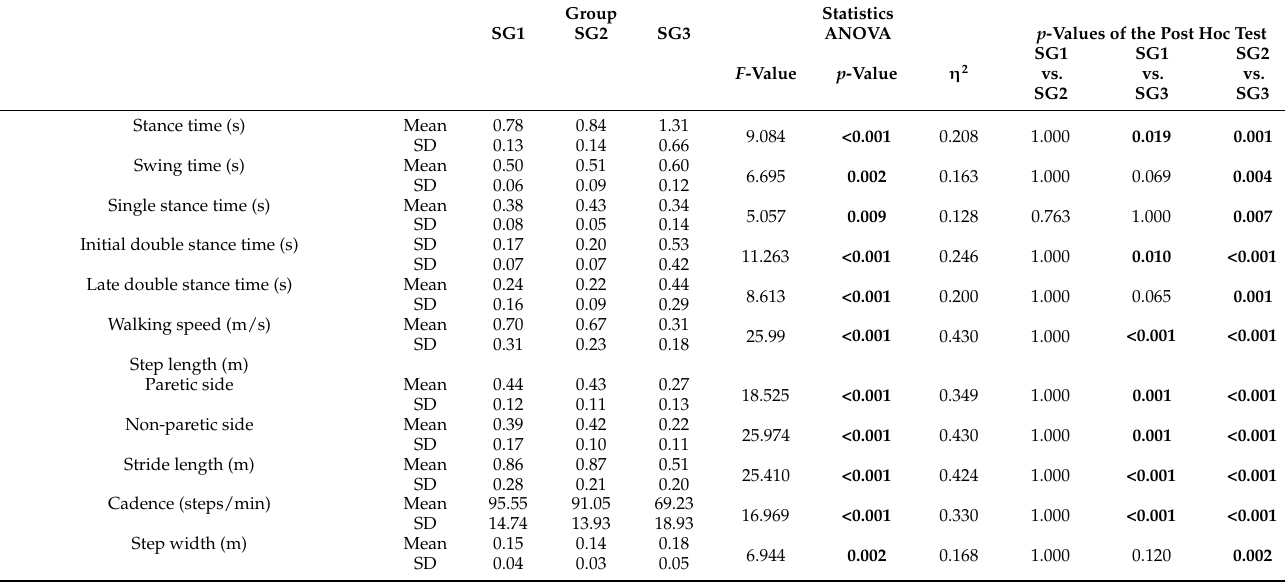
Table 2. Gait spatiotemporal parameters measured using a three-dimensional motion analysis system in the three subgroups. Group Statistics SG1 SG2 SG3 ANOVA p -Values of the Post Hoc